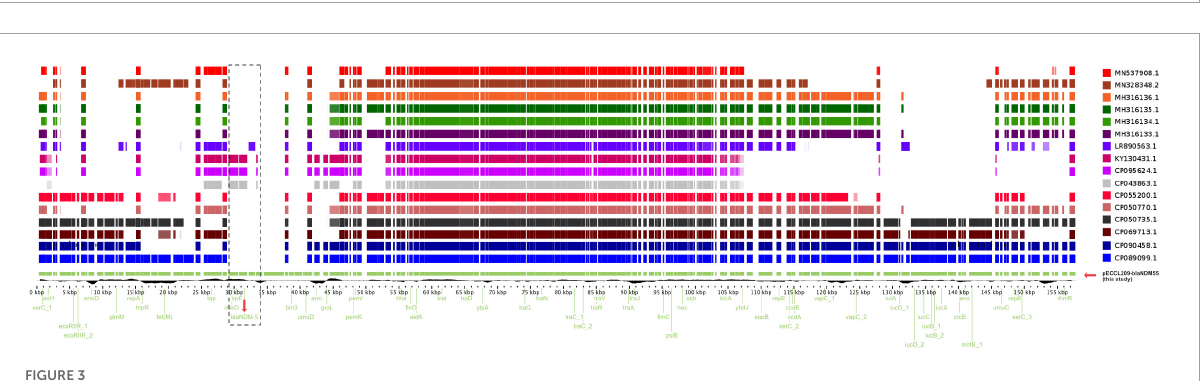
FIGURE2 Structure of the bla NDM − 5 -carrying plasmid and comparison of the genetic context of bla NDM − 5 . (A) BLAST tree comparison of plasmid pECCL209-blaNDM5 with other homologous plasmids available in the NCBI database. (B) Structure of the bla NDM − 5 -carrying plasmid pECCL209. (C) Sequence comparison of the genetic context of a plasmid carrying bla NDM − 5 gene from different sources. The arrows showed the direction of the transcription. Regions of > 99% of homology are displayed by gray shading.